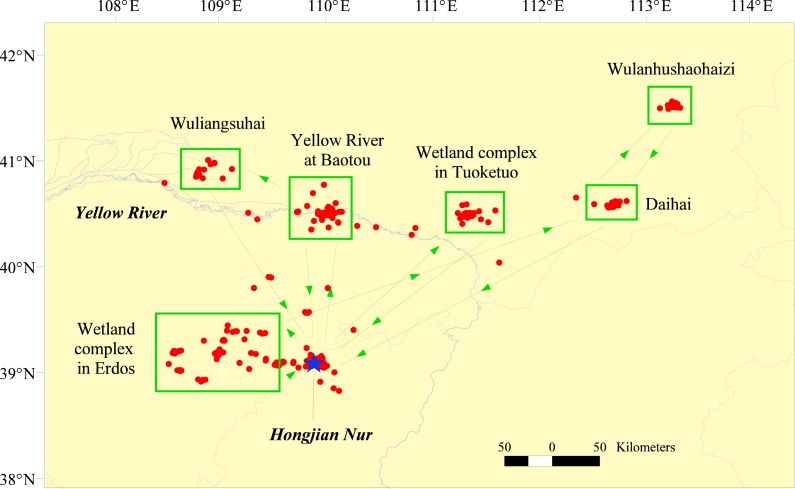
Pre-breeding dispersal sites and direction of satellite-tracked Relict Gulls after returning to Hongjian Nur during the spring migration from 2009–2012.